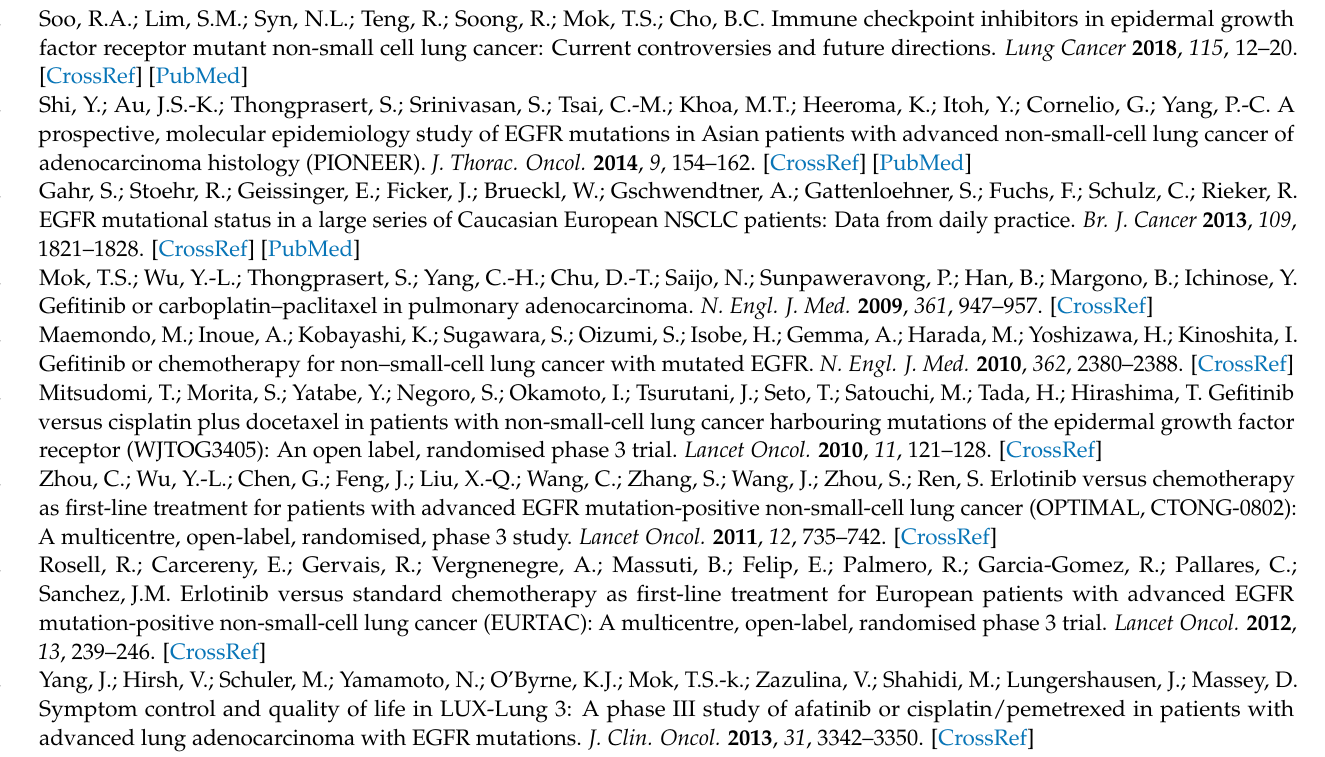
Figure S5: any-grade interstitial lung diseases. (A) Combination therapy with epidermal growth factor receptor tyrosine kinase inhibitor and immune checkpoint inhibitor. (B) Osimertinib monother- apy; Figure S6: grade ≥ 3 skin trAEs. (A) Combination therapy with epidermal growth factor receptor tyrosine kinase inhibitor and immune checkpoint inhibitor. (B) Osimertinib monotherapy; Figure S7: grade ≥ 3 gastrointestinal trAEs. (A) Combination therapy with epidermal growth factor receptor tyrosine kinase inhibitor and immune checkpoint inhibitor. (B) Osimertinib monotherapy; Figure S8: grade ≥ 3 interstitial lung disease. (A) Combination therapy with epidermal growth factor receptor tyrosine kinase inhibitor and immune checkpoint inhibitor. (B) Osimertinib monother- apy; Figure S9: sensitivity analysis on any-grade interstitial lung disease. (A) Combination therapy with epidermal growth factor receptor tyrosine kinase inhibitor and immune checkpoint inhibitor. (B) Osimertinib monotherapy, among studies with sample size ≥ 40; Figure S10: sensitivity analy- sis on grade ≥ 3 interstitial lung disease. (A) Combination therapy with epidermal growth factor receptor tyrosine kinase inhibitor and immune checkpoint inhibitor. (B) Osimertinib monother- apy, among studies with sample size ≥ 40; Table S1: summary of osimertinib monotherapy stud- ies; Table S2: ongoing clinical trials of immune checkpoint inhibitors (ICI) in advanced, metastatic non-small cell lung cancer; Table S3: incidence and nature of trAEs in selected clinical studies; Table S4: the Cochrane Collaboration’s tool for assessing risks of bias of randomized-controlled trials; Table S5: newcastle-Ottawa Scale (NOS) for quality assessment of non-randomized-controlled